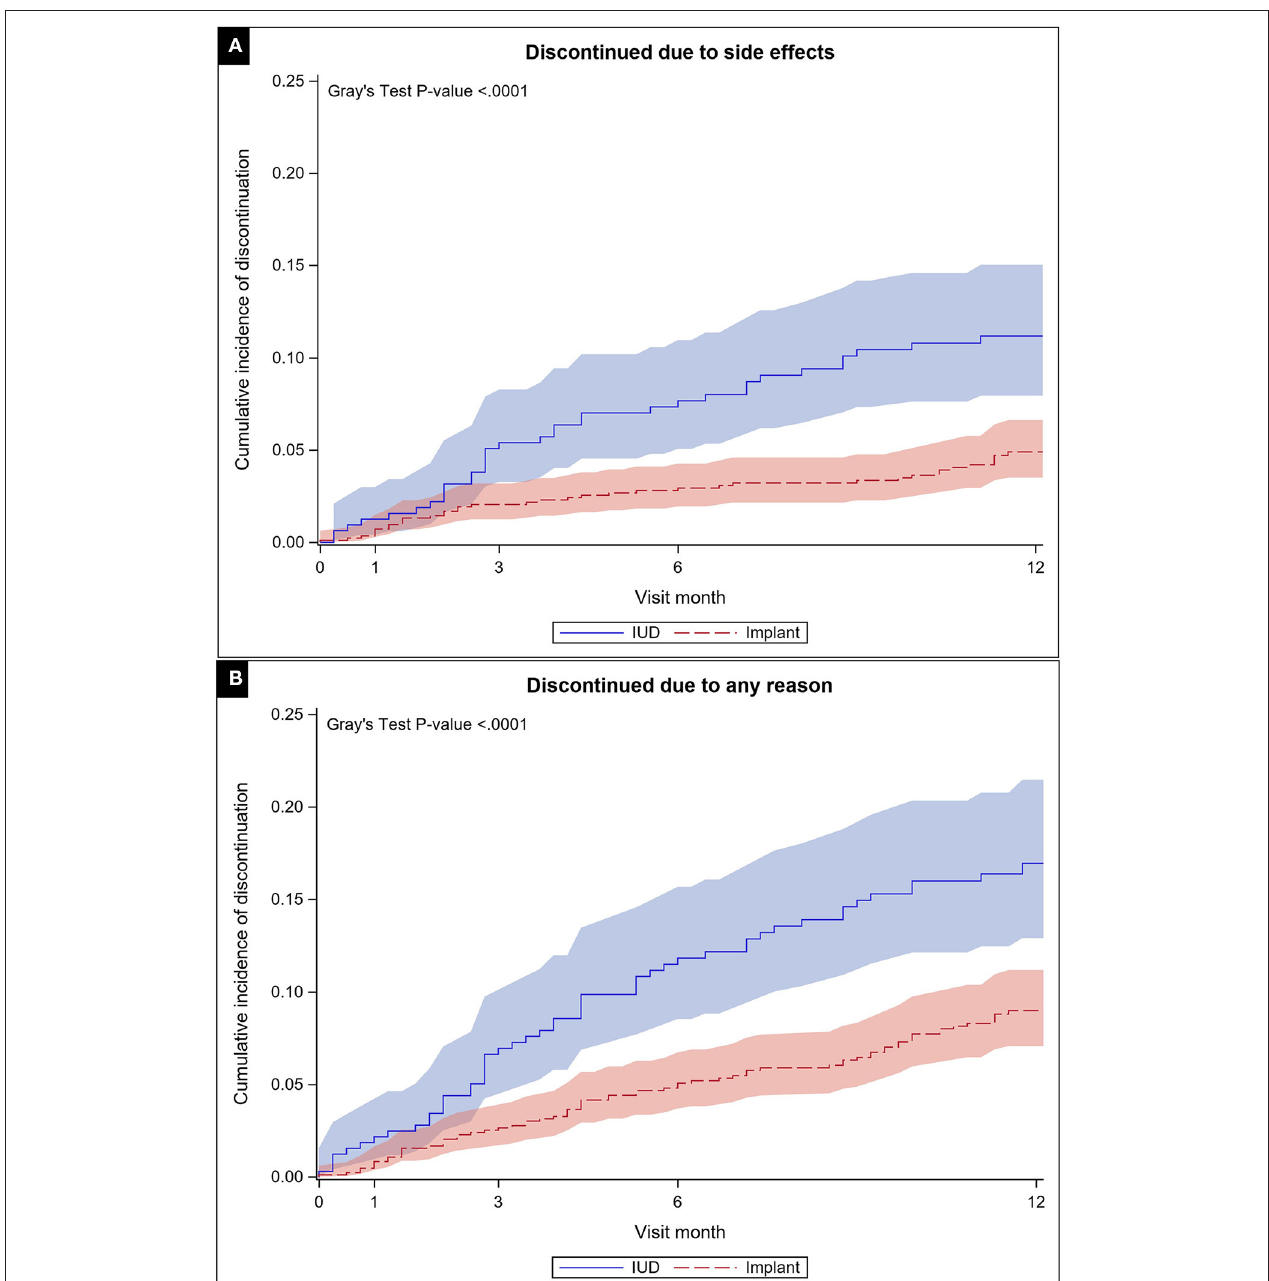
FIGURE 2 | Cumulative incidence function with confidence limits for discontinuation due to side effects (A) and all-cause (B) through 12 months of follow up by method chosen at